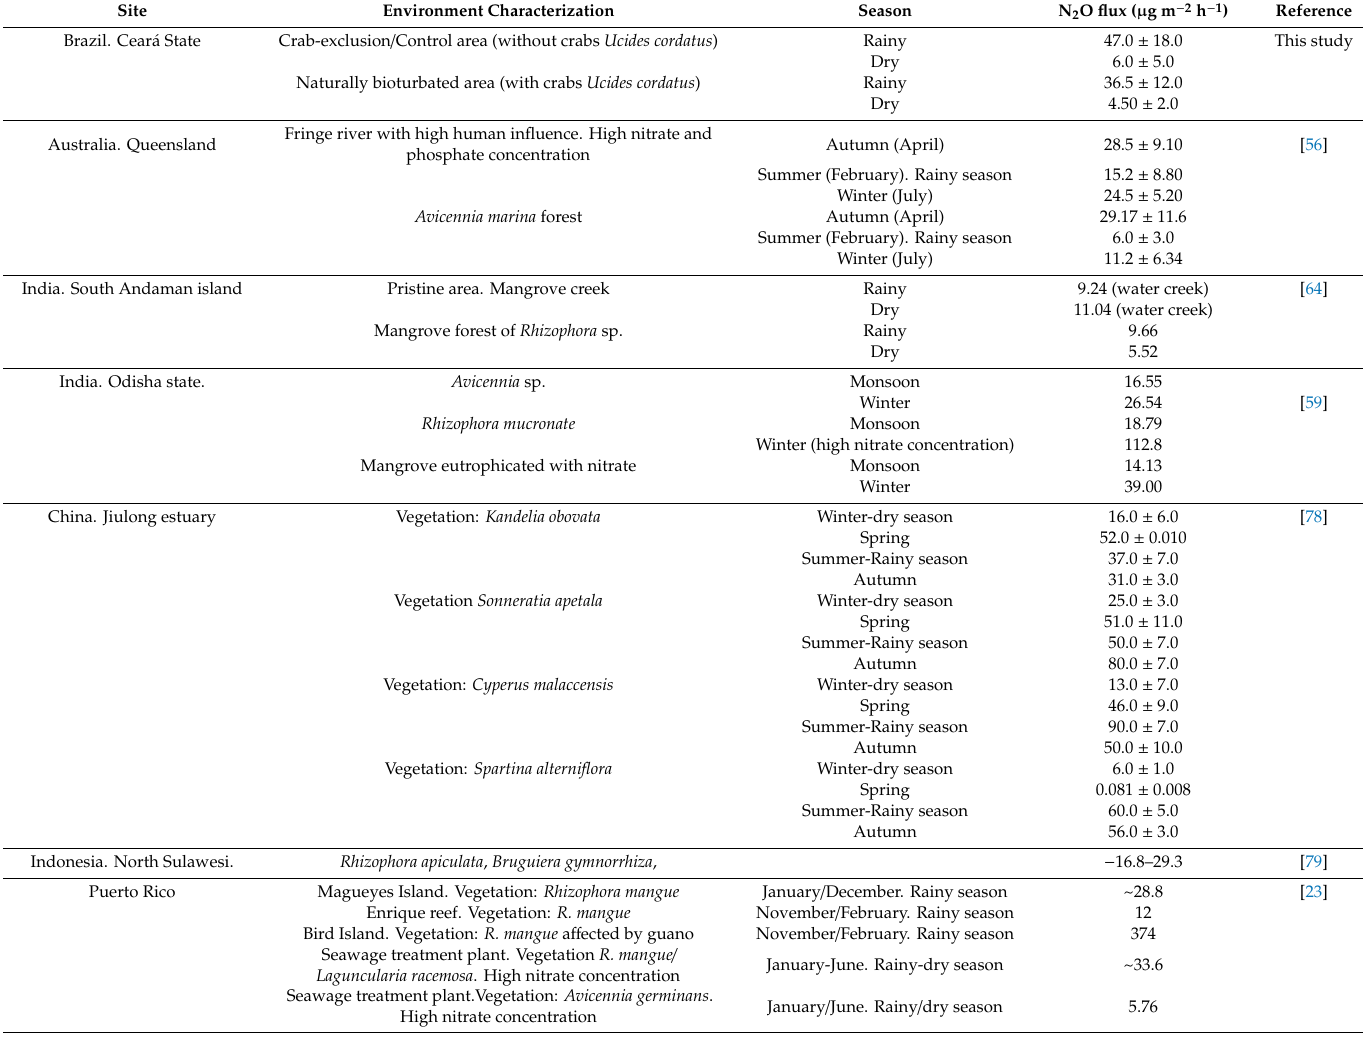
Table 1. N 2 O fluxes of di ff erent mangrove and estuarine forests